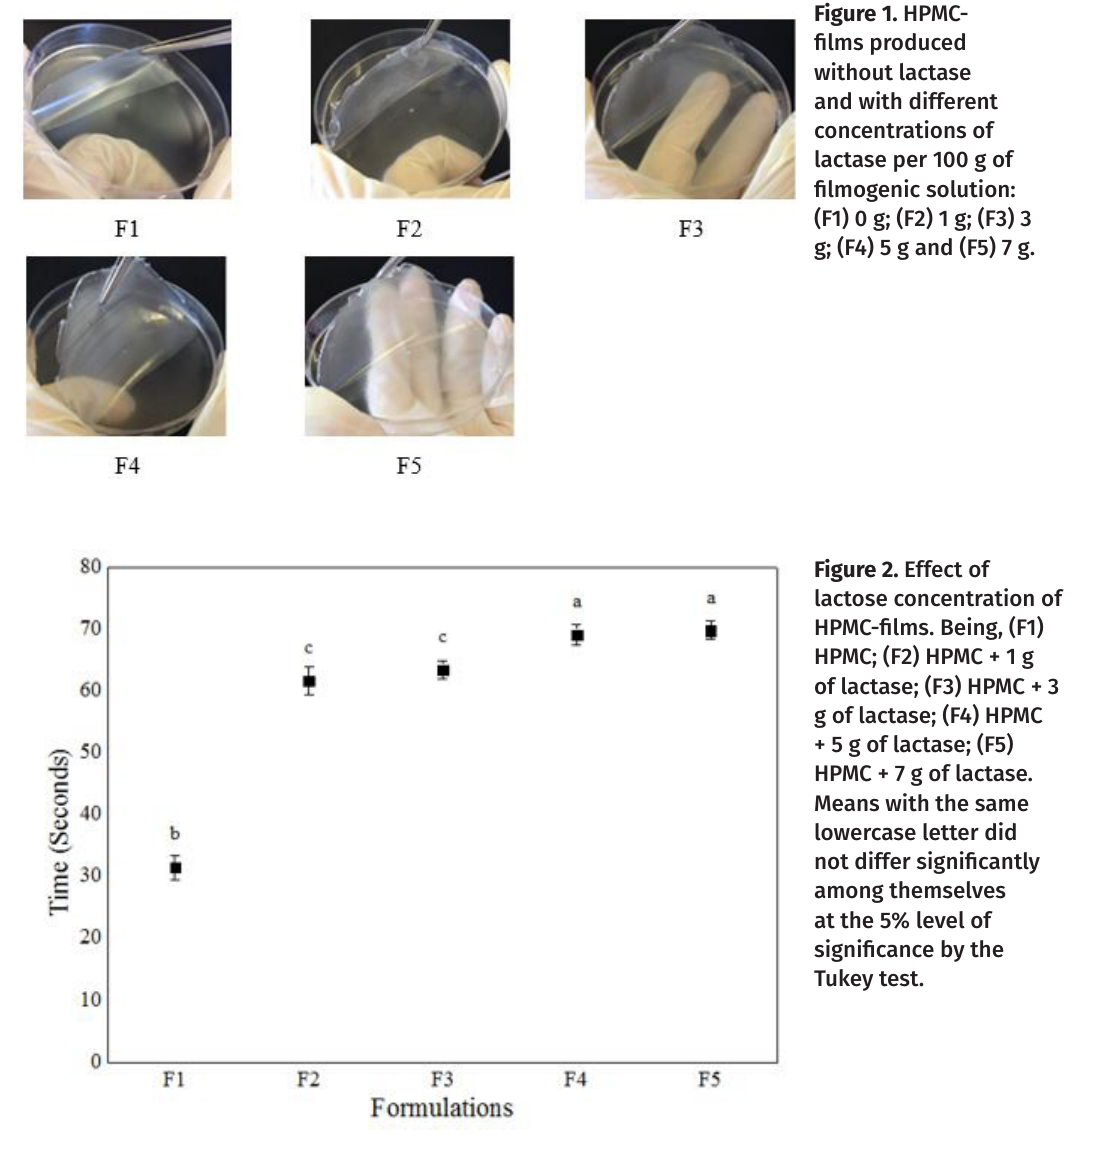
Figure 1. HPMC- films produced without lactase and with different concentrations of lactase per 100 g of filmogenic solution: